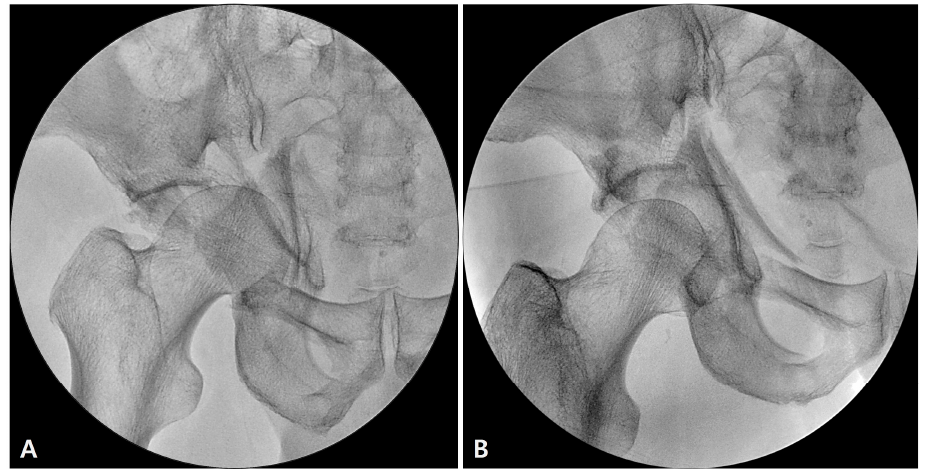
Figure 3. Intraoperative image before ( A ) and after ( B ) traction.